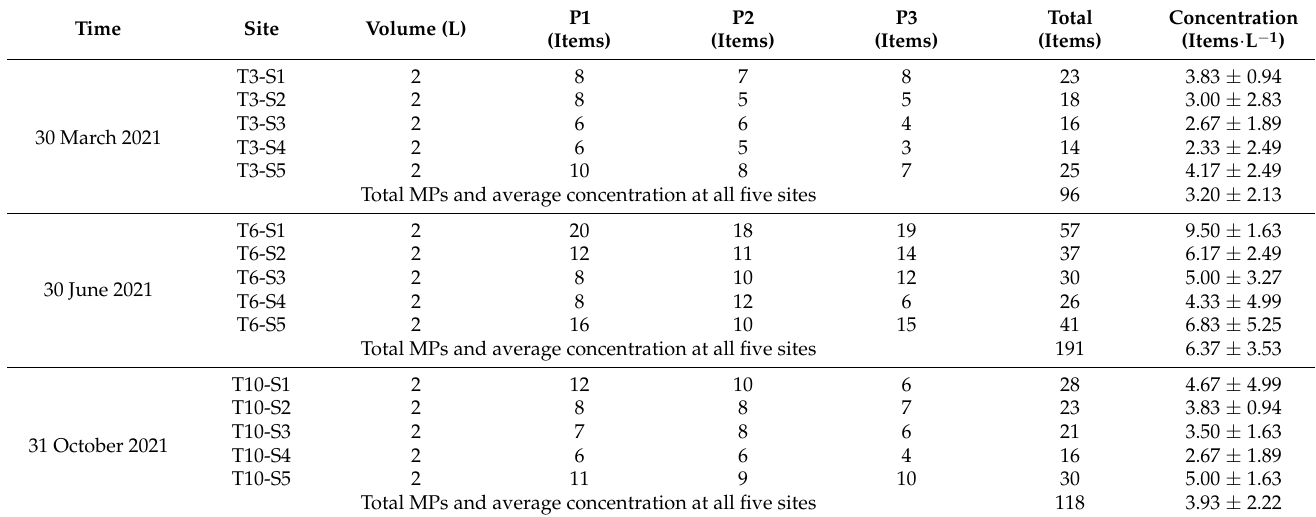
Table 4. Distribution of the microplastic at the sampling